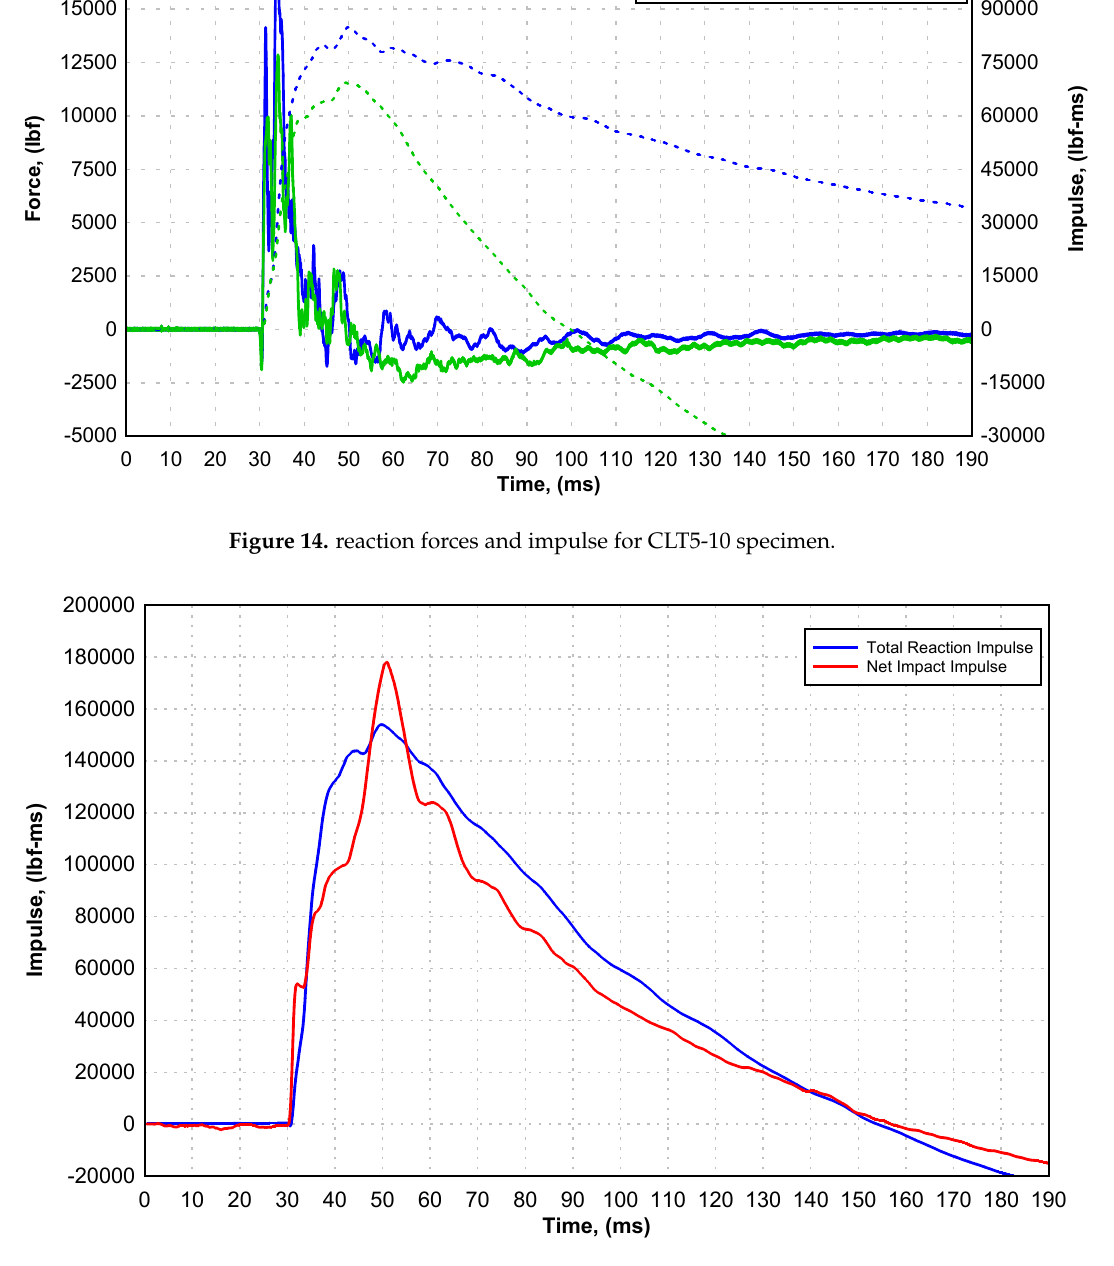
Figure 15. Net impact and reaction impulses for the CLT5-10